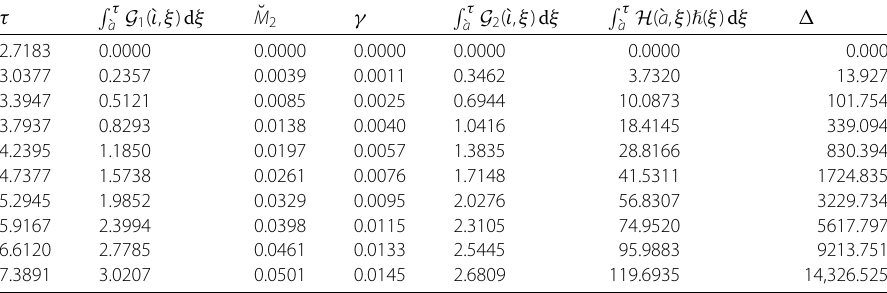
(cid:25) ` ι ` ι , ξ ) d ξ , ˘ M G 1 ( ` a